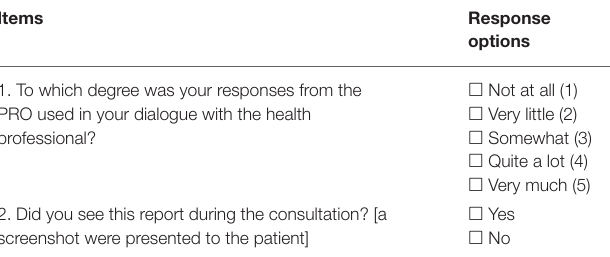
TABLE 3 | Self-constructed items to measure use of PRO and patient profile.